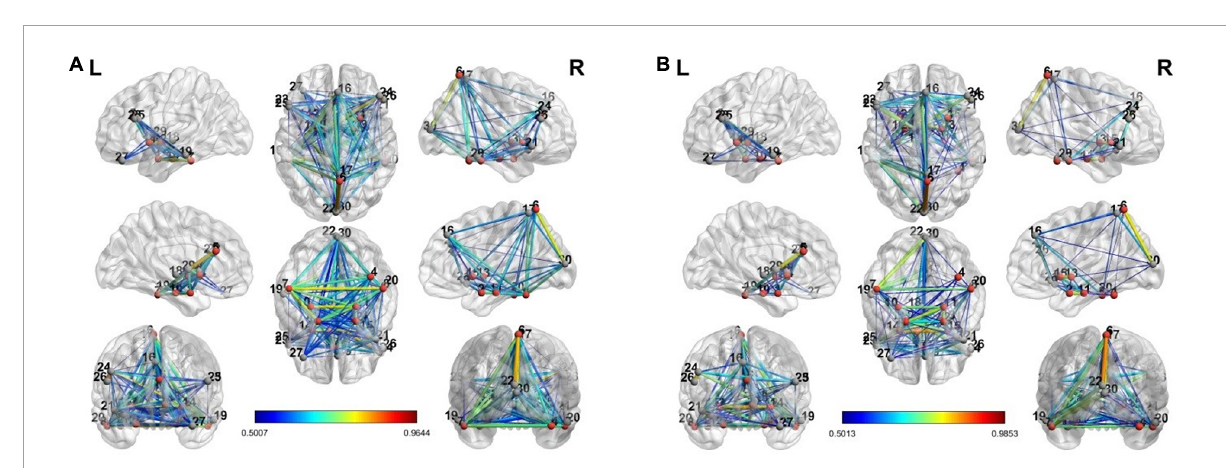
FIGURE4 The connectivity graph of view and upregulation states from different views in the brain: (A) view state, (B) up-regulation state.